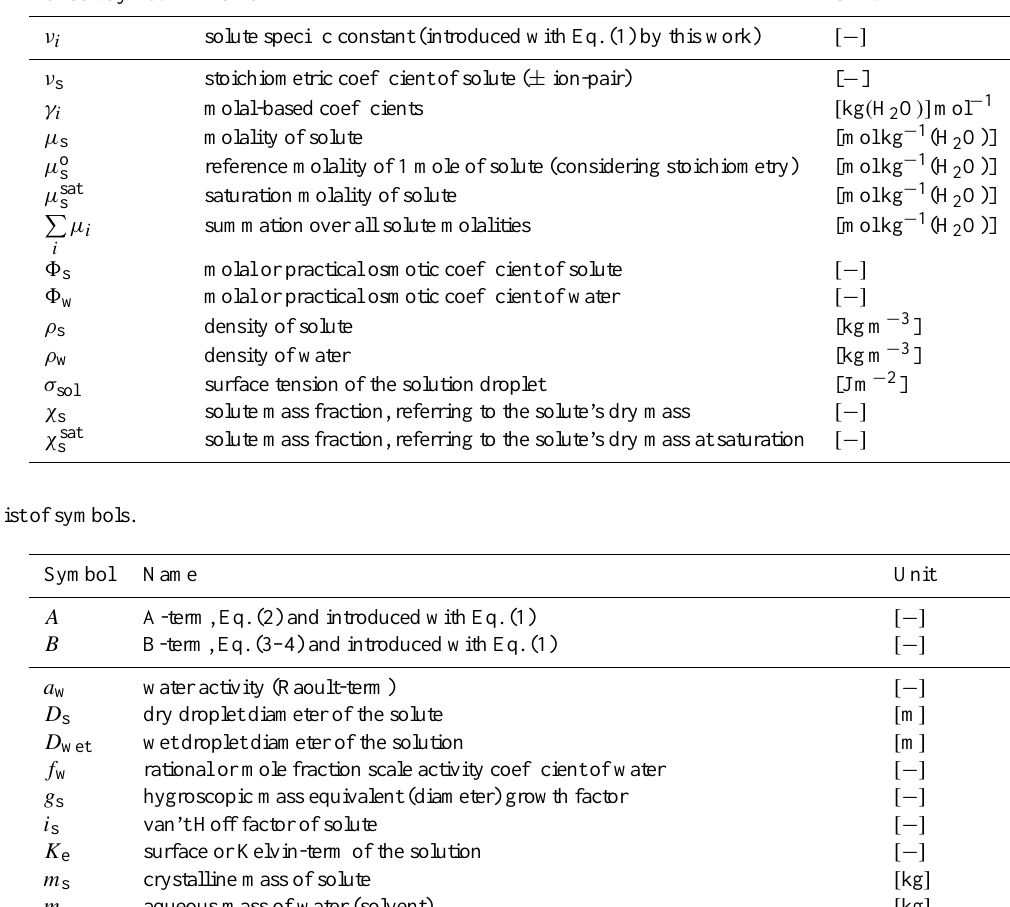
Table A1. List of greek symbols. Greek Symbol